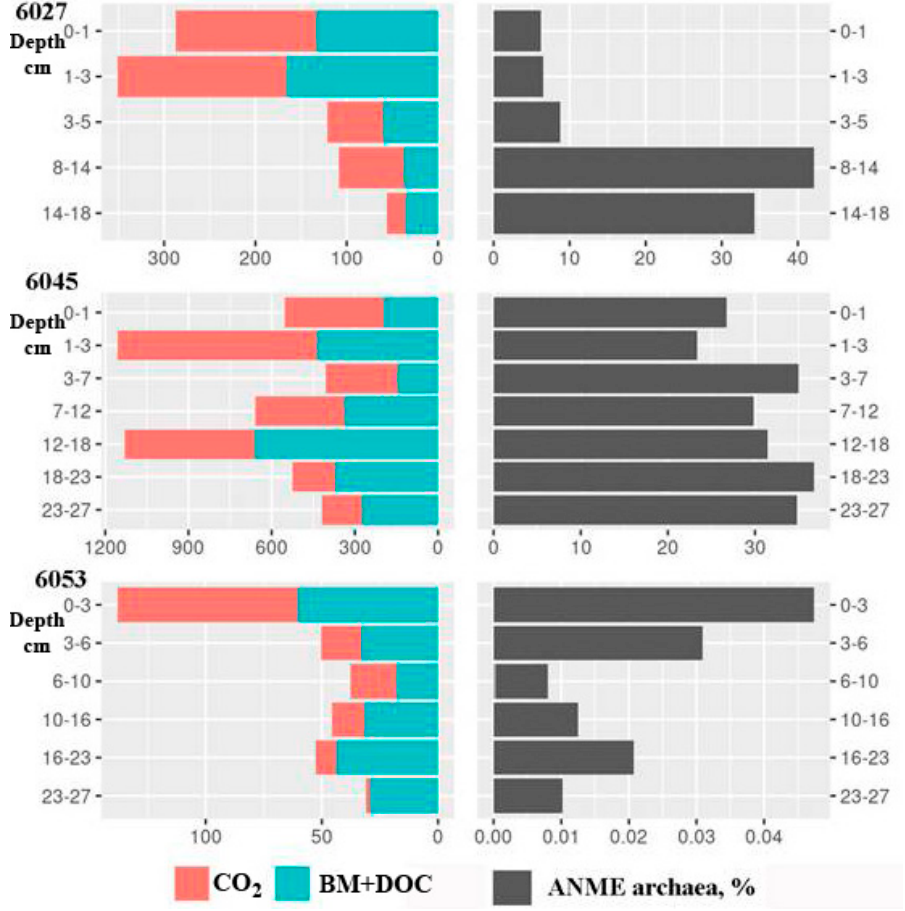
14 of 22 Figure 9. Rates of autotrophic (hydrogenotrophic) methanogenesis (MGh), nmol dm ‒ 3 day ‒ 1 ) in the Laptev Sea shelf sediments. The absolute values of MGh rates in the studied sediments were low (0.4–5.0 nmol dm − 3 day − 1 ) and similar for all stations (the methane seep zone, its periphery, and the ref- erence zone outside the seep). The 6–10 cm layer of st. 6053, with the rate of 12.0 nmol dm − 3 day − 1 , was somewhat exceptional in this respect. Thus, MGh occurring in the studied sediment layers contributed insignificantly to the total methane content (Figure 3). In the sediments of st. 6027, the rate of methane generation regularly increased with depth, in- dicating better conditions for the activity of hydrogenotrophic archaea in deeper horizons. The absolute values of MO rates in the sediments of all three stations were signifi- cantly higher than the rates of methanogenesis (Figure 10). This indicated that most me- thane was delivered to the upper sediment horizons from lower layers. Active MO was observed for the sediments of st. 6045 (from 400 to 1200 nmol dm − 3 day − 1 ), where the layers with high and low MO activity were located without visible regularity. MO rates in the sediments of the seep periphery (st. 6027) were lower (from 55 to 350 nmol dm − 3 day − 1 ). While MO rates in the sediments of the reference st. 6053 were even lower (from 30 to 130